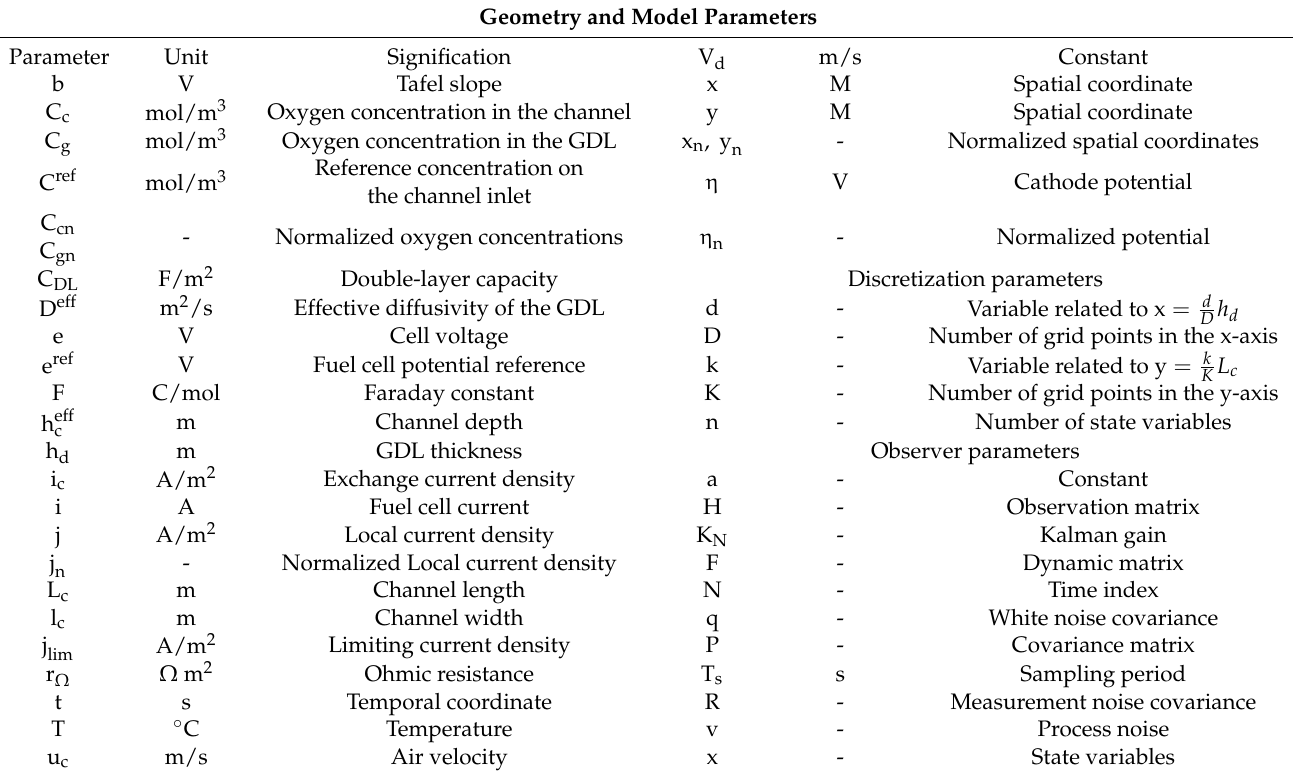
Table 1. Parameters and variables of